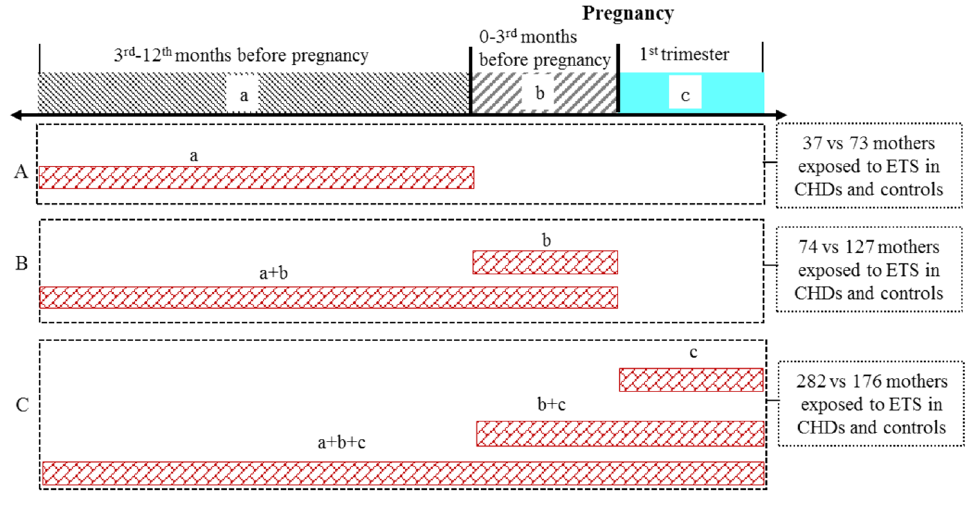
Figure 1. Exposure duration